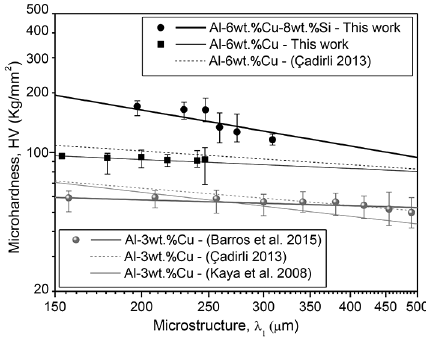
Figure 4 - Comparison of Hall-Petch experi- mental expressions obtained in this work and literature, according to Table I for Al-(3 and 6) wt.%Cu